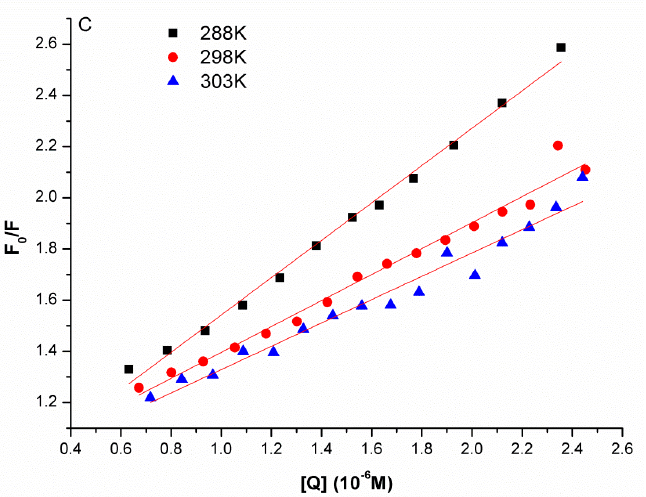
Figure 4. Stern-Volmer plots describing JW-3 quenching caused by the subunit H of V-ATPase at three different temperatures. Table 1. The Stern-Volmer quenching constant K sv of JW-3-V-ATPase subunit H system at different temperatures were deduced from Figure 4.